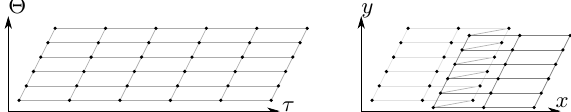
Facade GridSensor Grid